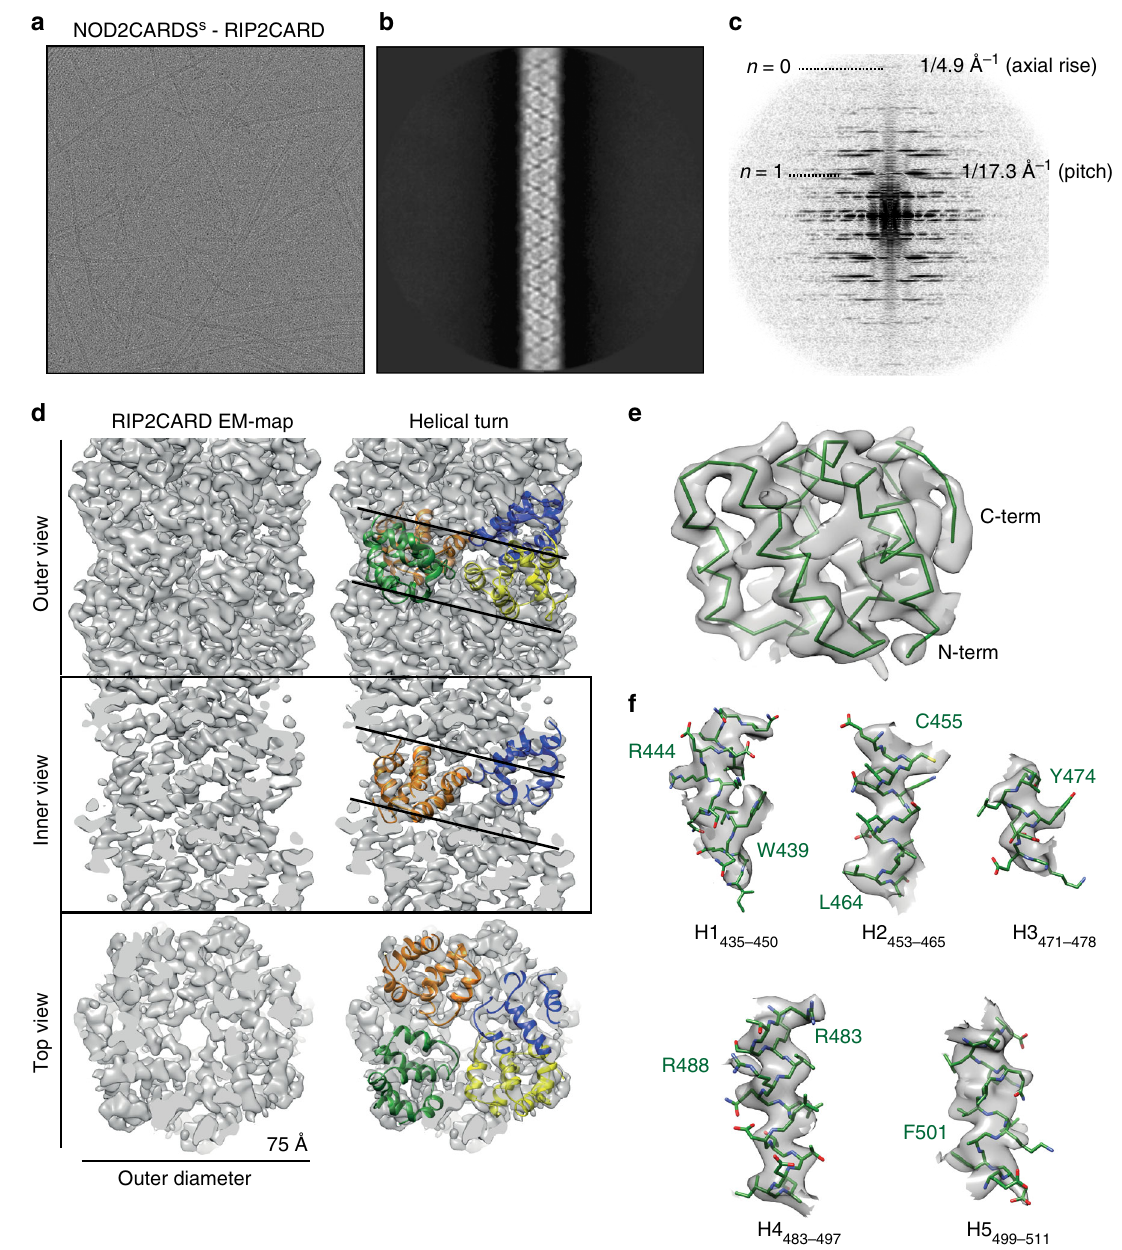
Fig. 6 Cryo-EM structure of the RIP2CARD fi lament. a Cryo-EM image of NOD2CARDS s -RIP2CARD fi laments used for structure determination. b , c 2D- class average ( b ) and corresponding power spectra ( c ) used for initial symmetry parameter estimation. d Final cryo-EM map of the three-dimensional RIP2CARD fi lament at 3.94 Å resolution (FSC in Supplementary Fig. 8c). Outer, inner and top view without (left) and with (right) RIP2CARD models fi tted into one helical turn. e View of the RIP2CARD monomer fi tted into the EM map showing only the main chain for clarity. f Zoomed-in views of the fi tting of individual α -helices into the sharpened cryo-EM density. Helices are de fi ned as in the sequence alignment (Supplementary Fig. 4) except for H1, which starts from I435 in the RIP2CARD monomer within the fi lament. Sidechains are shown as stick models. A few residues with clear EM density for sidechains are